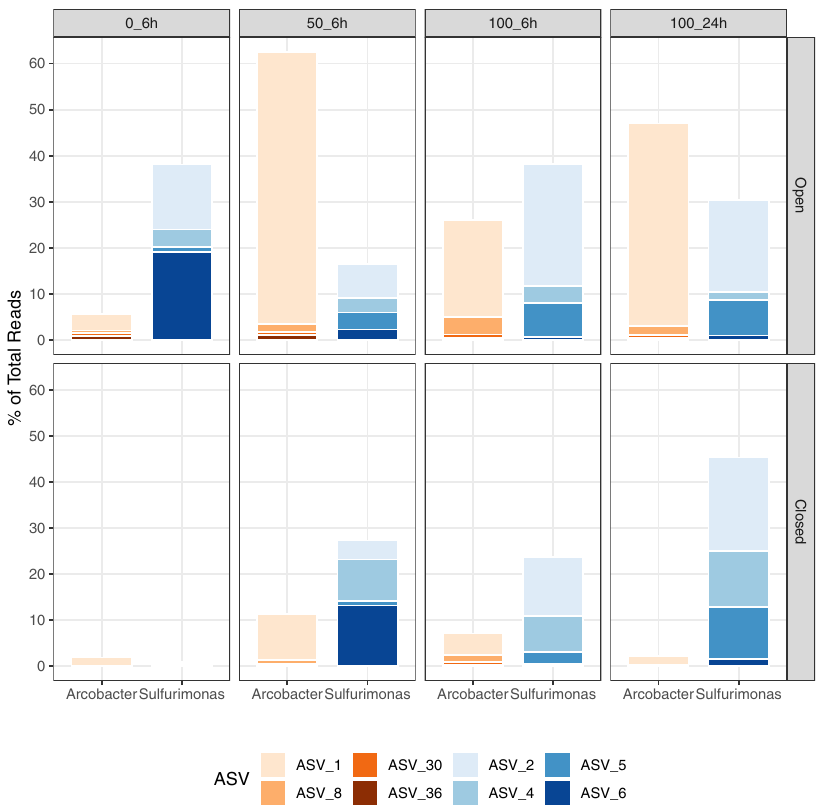
Fig. 6 The four most abundant amplicon sequence variants of Arcobacter and Sulfurimonas . The four most abundant amplicon sequence variants (ASVs) of Arcobacter (1, 8, 30, and 36) and Sulfurimonas (2, 4, 5, and 6) in the surface layer of open and closed in situ incubations along the transect at 0, 50, and